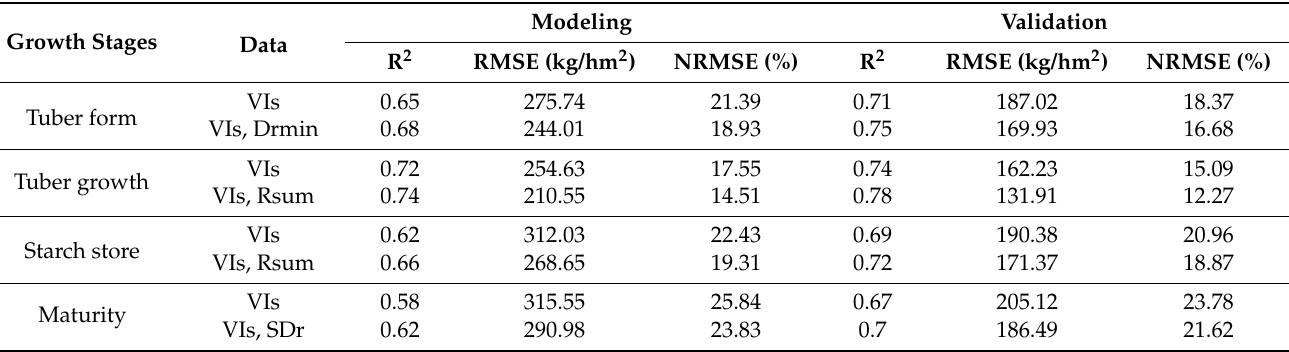
Table 6. PLSR-based estimates of potato AGB at different growth stages.